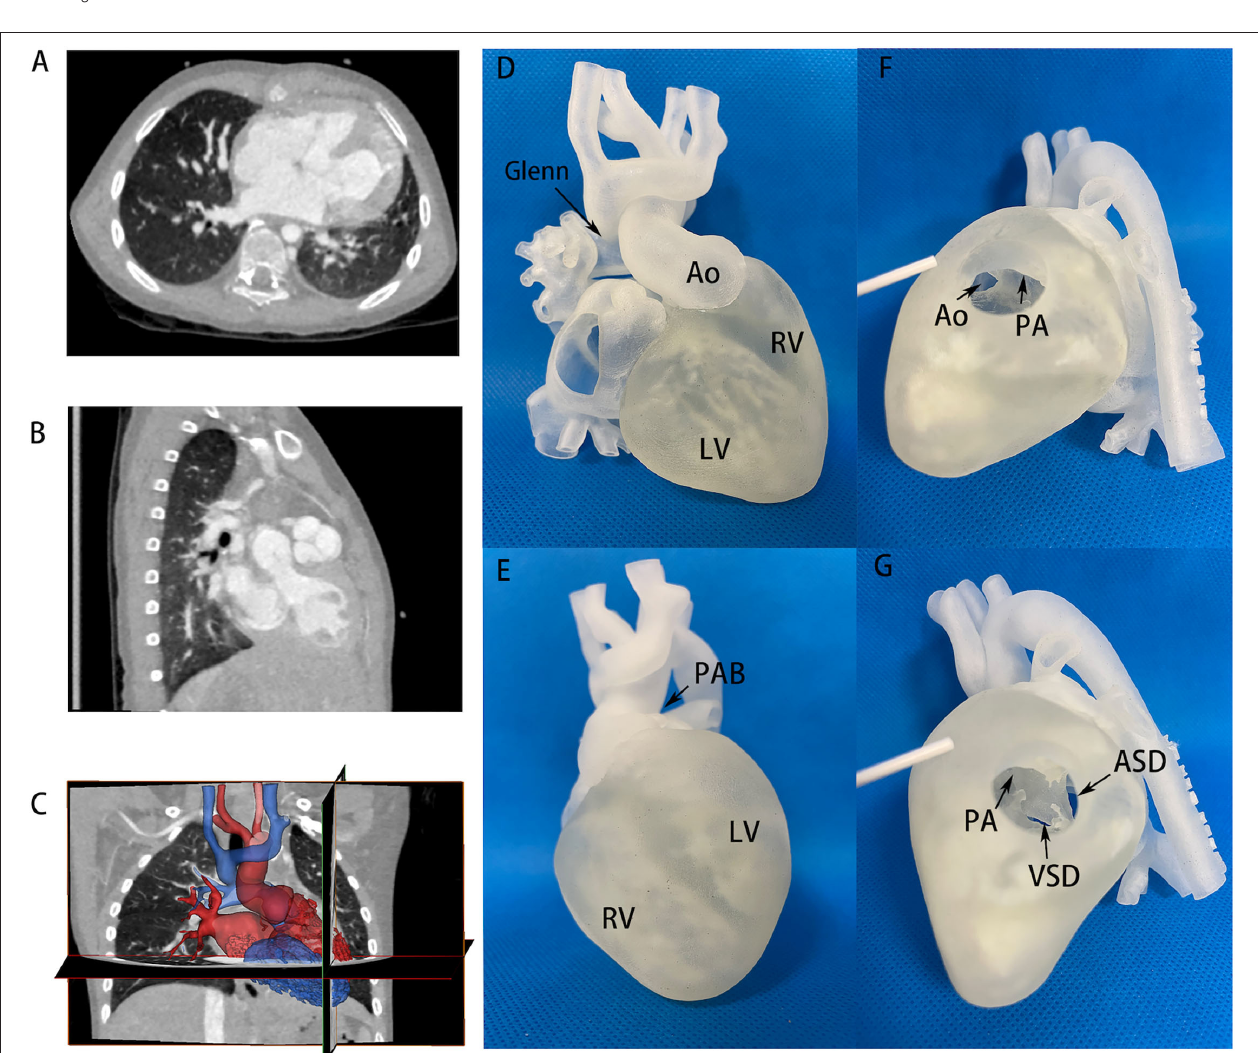
FIGURE 2 | CT images and 3D printing model of case No. 3 in the balanced ventricular group. (A,B) CT images providing flat information of two well-developed ventricles, VSD size and location, atrioventricular discordance evidence. (C) Segmentation and reconstruction of the 3D model based on CT images, where red and blue color distinguished the two ventricles and circulation. (D,E) 3D printing models in anterior and inferior view, showing two well-balanced ventricles. The aorta and PA were in an anterior-posterior relationship. Glenn and PAB site in primary operation could also be seen. (F,G) 3D printing models on the right ventricular incision. Aorta and PA derived from right ventricles were observed. Ao, aorta; LV, left ventricle; RV, right ventricle; PA, pulmonary artery; PAB, pulmonary artery banding; VSD, ventricular septum defect; ASD, atrial septum defect. which between two groups was conducted by t -test. Categorical variables were reported in the form of the frequency with percentage (%) and the comparison was made by chi-square test. P -values < 0.05 were considered statistically